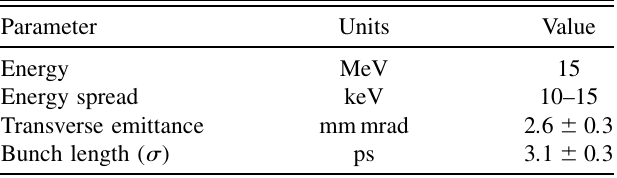
TABLE I. Summary of nominal electron-beam parameters for operations at A0PI with 250 pC per micropulse and a drive laser bunch length of 2.7 ps